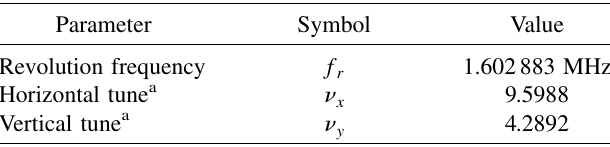
TABLE II. Storage-ring parameters under the vertical quadrupolar-tune measurement. The other parameters are the same as those in Table I.